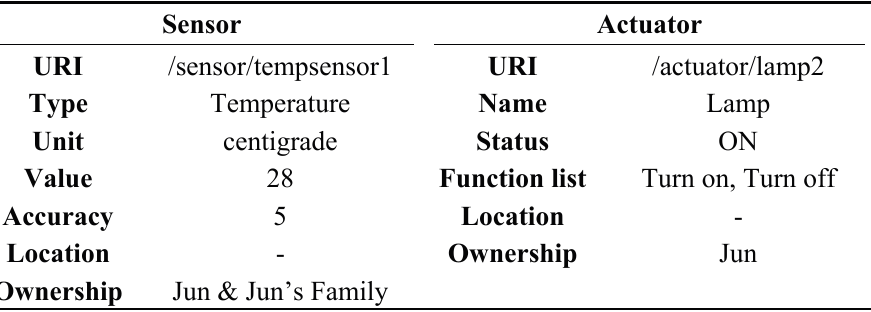
Table 1. Object-data